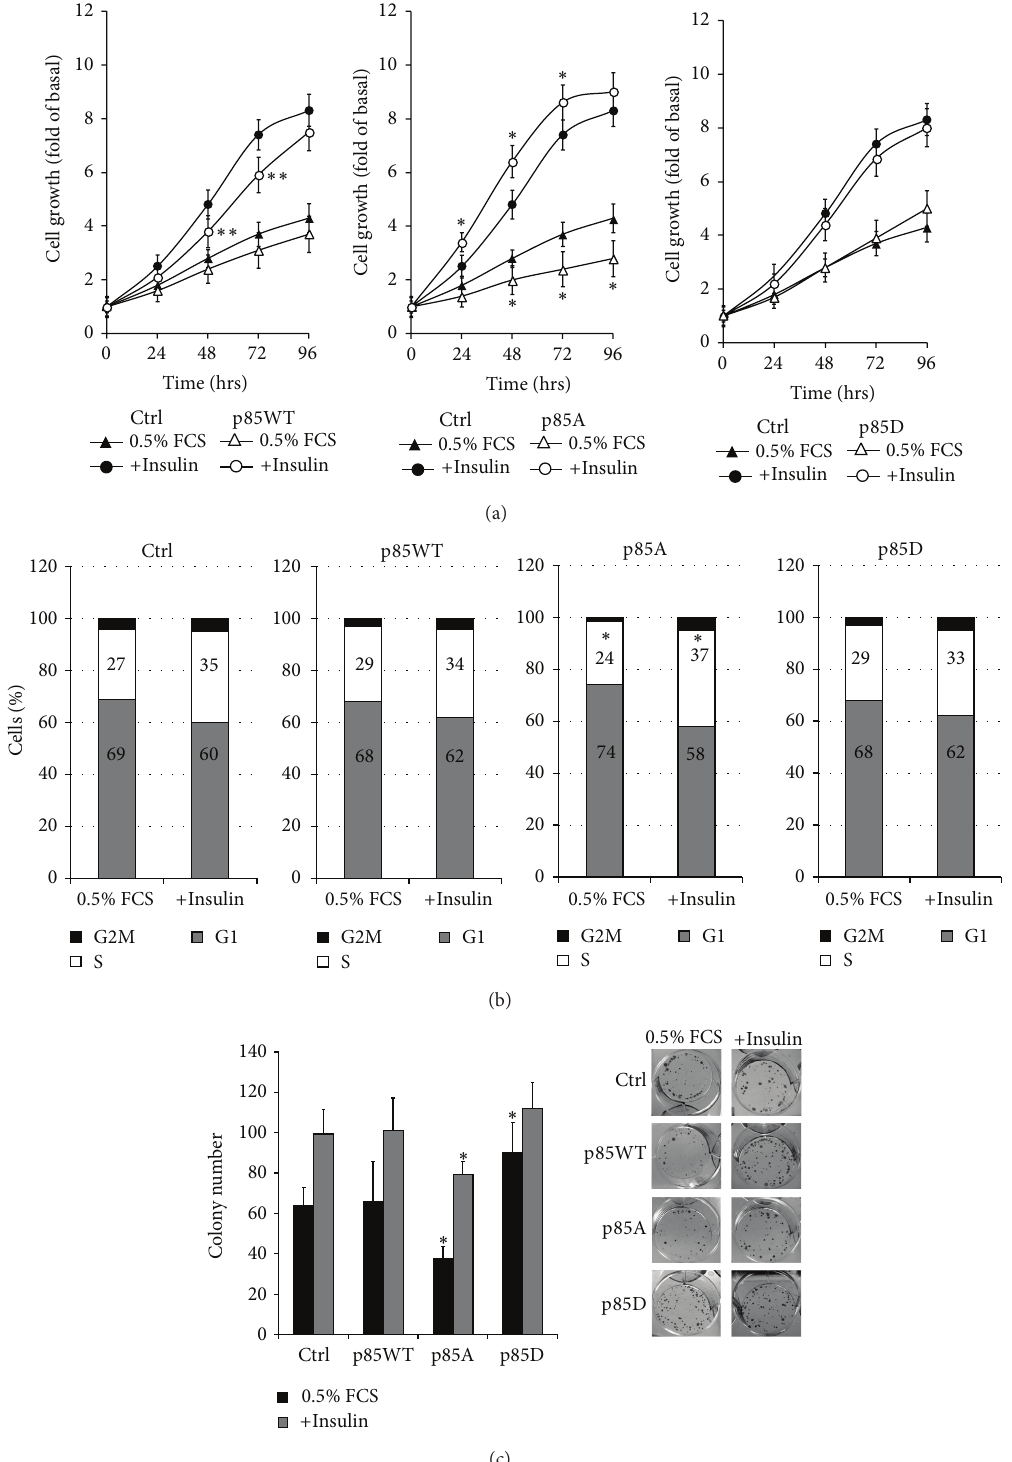
Figure 4: Effects of p 85𝛼 PI 3 K S83 phosphorylation on MCF-7 cells proliferation and viability. (a) MCF-7 cells transiently transfected with p85WT, p85A, or p85D or with the empty vector were treated with 10nM insulin or with 0.5% FCS. For the colorimetric MTT assay (A) cells were counted after 0, 24, 48, 72, and 96 hours ( ∗∗ 𝑃 < 0.01 compared to the control; ∗ 𝑃 < 0.01 compared to p85WT or p85D). (b) Cell cycle analysis was performed by fluorocytometric absorbent cell sorter (FACS) to determine the percentage of cells in G2 M, S and G1-phase ( ∗ 𝑃 < 0.01 compared to empty vector or p85WT or p85D). The data are the mean of three independent experiments performed in triplicate ( 𝑛 = 9 ). (c) For the clonogenic assay transfected cells were seeded into 6 multiwell plates in the presence of 10 nM insulin. Twenty-four hours later insulin was removed or lowered to 5nM. Fifteen days later the clones were counted and their cellularity was evaluated by contrast microscopy. Clones were counted after 30 󸀠 fixing with a mixture of 6% glutaraldehyde and 0.5% crystal violet. The histogram represents the average number of colonies of four separate experiments performed in duplicate ( 𝑛 = 8 ). ( ∗ 𝑃 < 0.01 versus empty